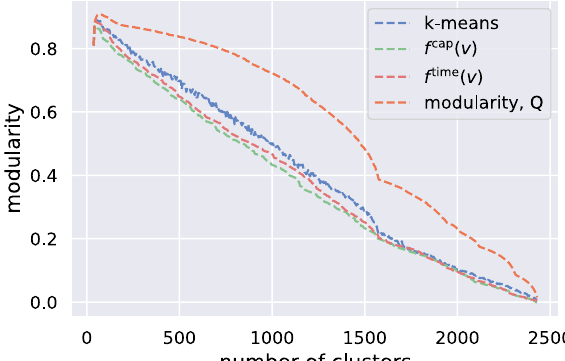
Fig. 6 Modularity respective clustering method: The x-axis displays the number of resulting regions (clusters), the y-axis the modularity of the resulting graph according to equation (6)